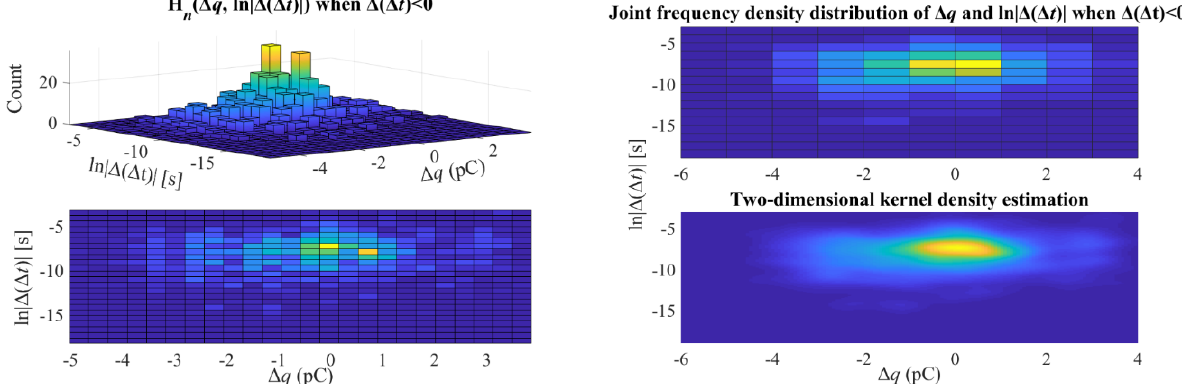
Figure 9. The illustration of H n ( Δ q , ln| Δ ( Δ t )|) and the corresponding result of two − dimensional kernel density estimation when Δ ( Δ t) < 0.